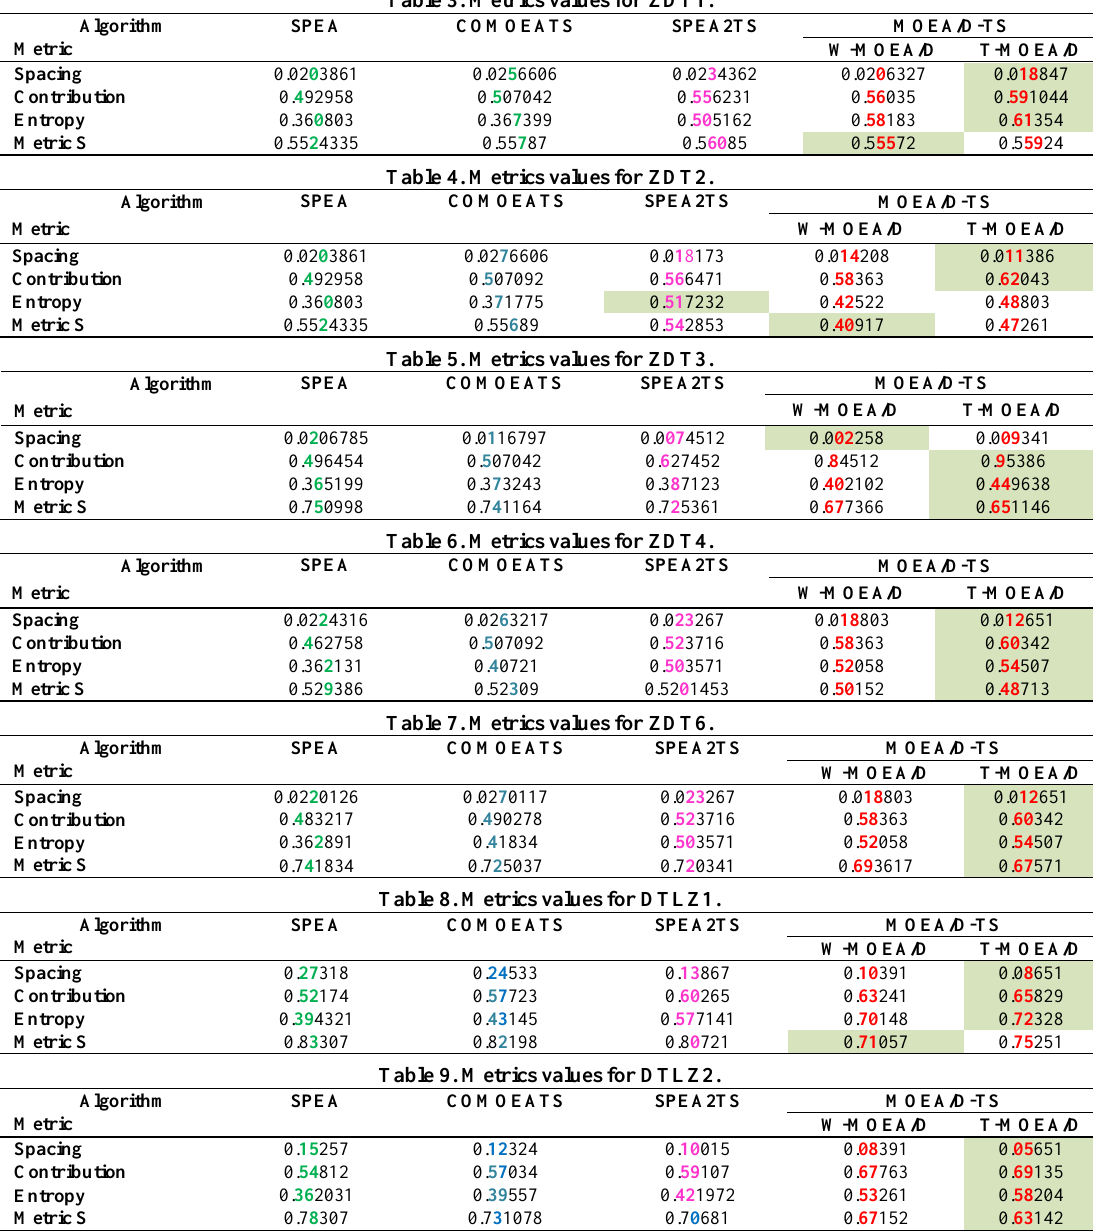
Table 3. Metrics values for ZDT1.